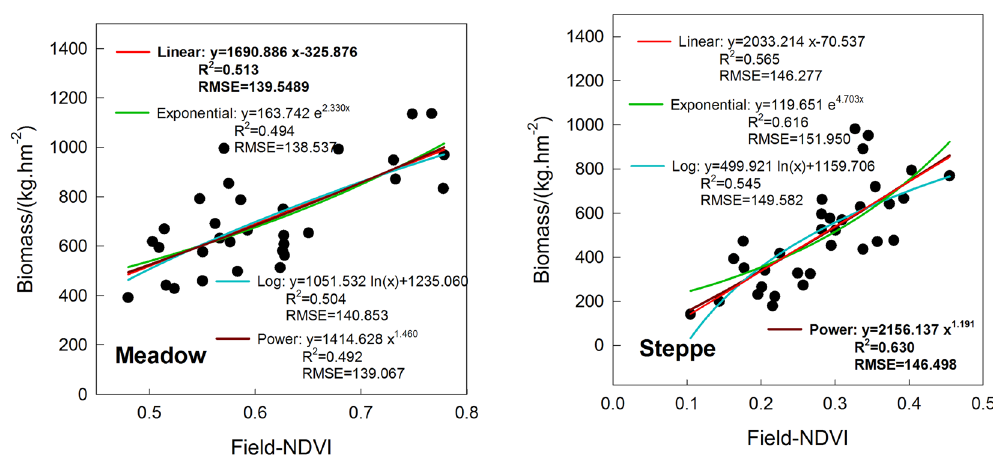
Figure 3. Regression models (linear, exponential, log, and power functions) of field recorded aboveground biomass and field-measured NDVI for the meadow and